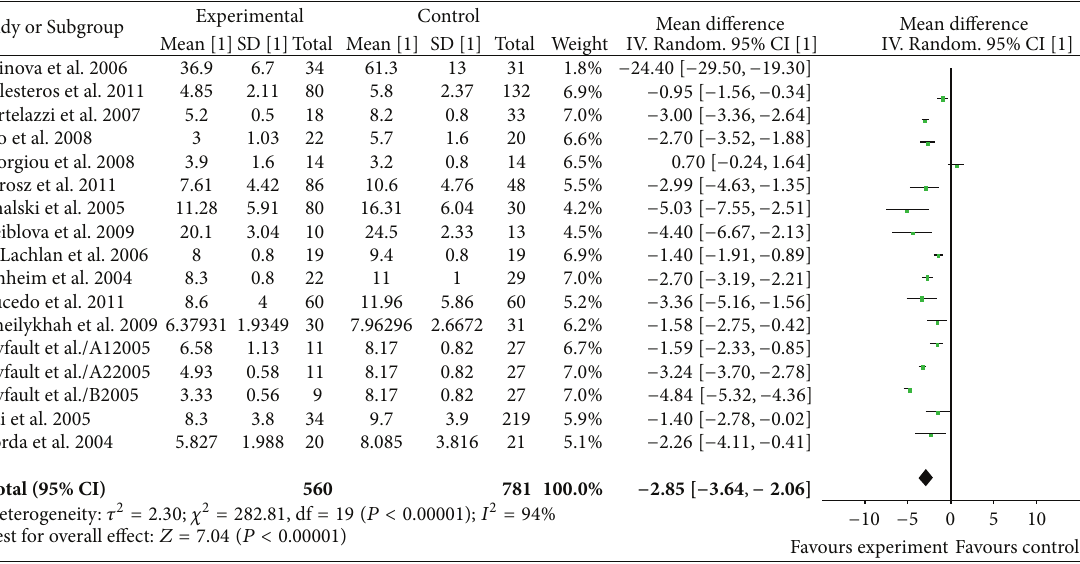
Figure 4: Mean difference (MD) and 95% CI of individual studies and pooled data for the association of maternal concentration of adiponectin with GDM risk. Positive values denote higher in GDM patients; negative values denote higher in healthy control subjects.